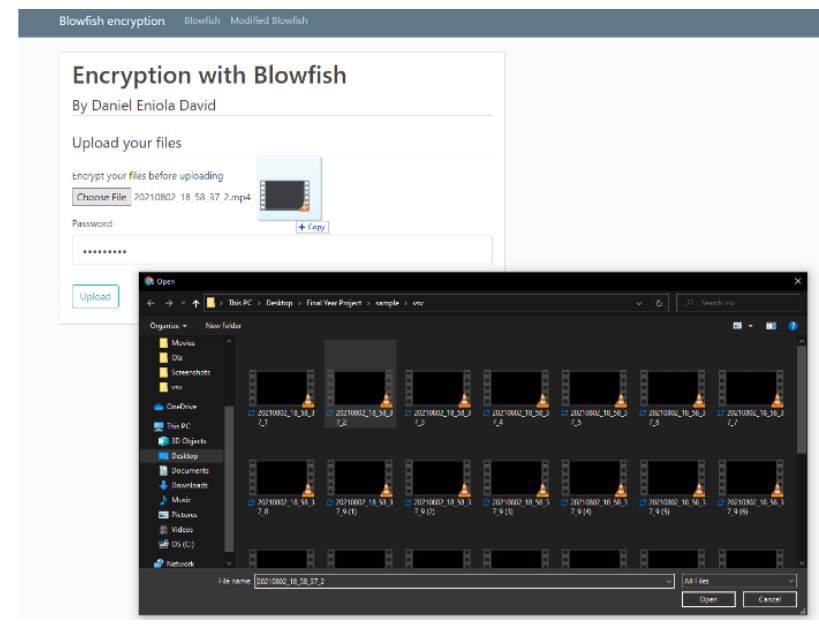
Figure 4. The selection process of video encryption app.